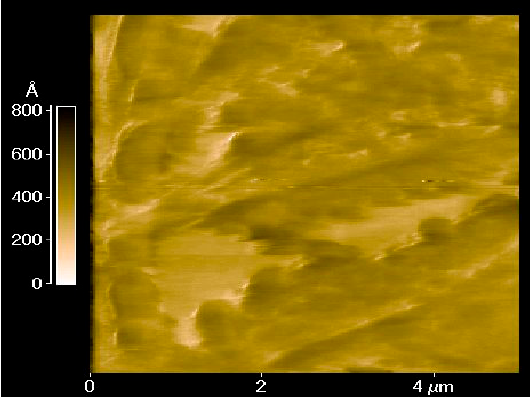
Figure 9. AFM image (tapping mode) of the sample of the hybrid metal–mesogenic nanosystem “Ag—4-cyano-4 ′ -octylbiphenyl” (1/10) in the smectic phase. (The topology of the sample surface (the height) is presented by the color –the color scale is presented at the left part of the picture).